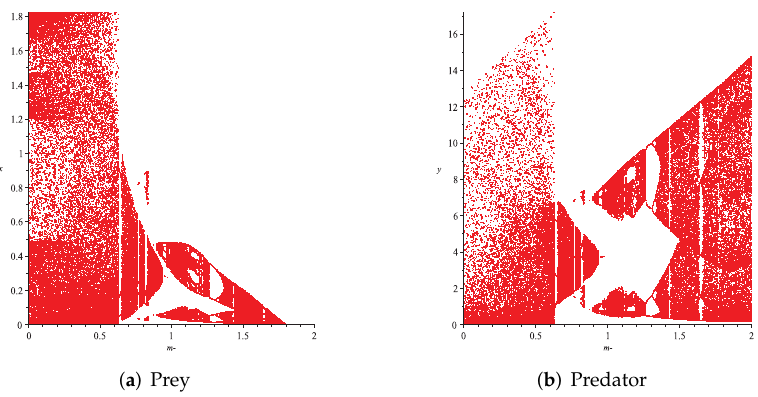
Figure 15. Variation of prey and predator densities with parameter m ( k = 0, r 0 = 3, h = 3).